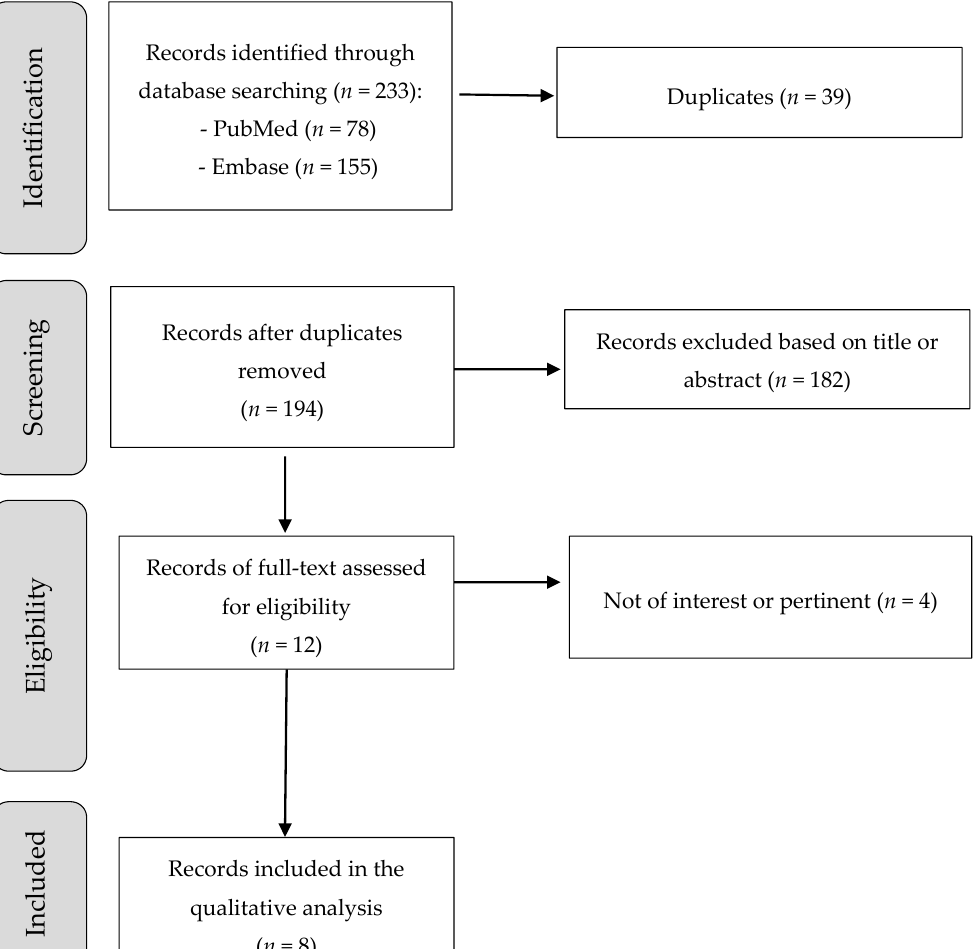
Figure 1. Flowchart of the study selection process.